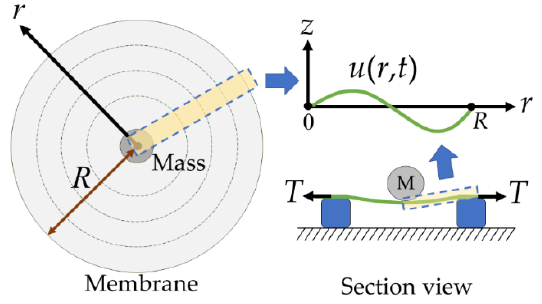
Figure 1. Top and section views of the circular